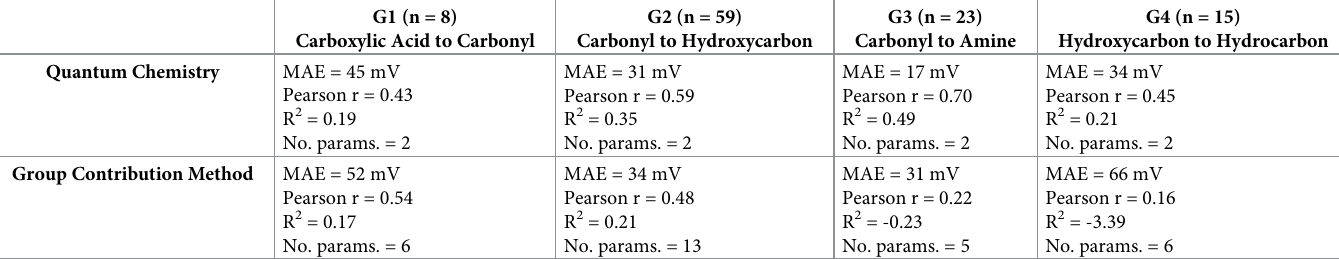
Table 1. Prediction accuracy of the quantum chemistry and group contribution method modeling